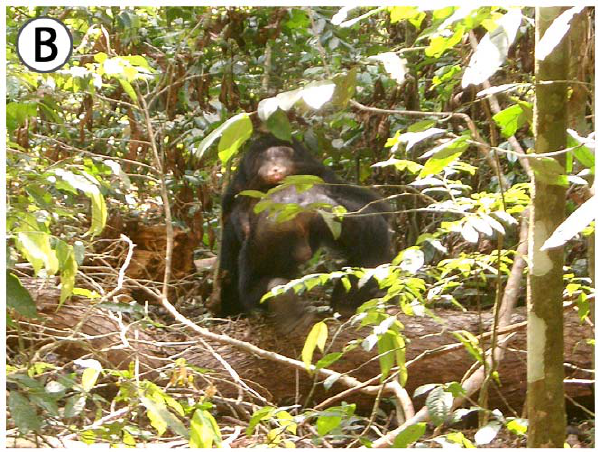
Figure 4. The adult male Porthos carrying on his back the adopted female infant